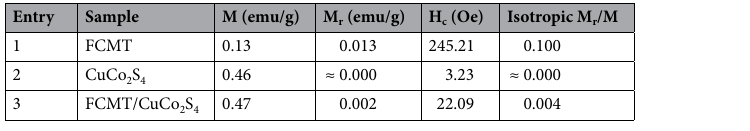
Table 1. Summarized magnetic characters of FCMT, CuCo 2 S 4 , and FCMT/CuCo 2 S 4 structures.